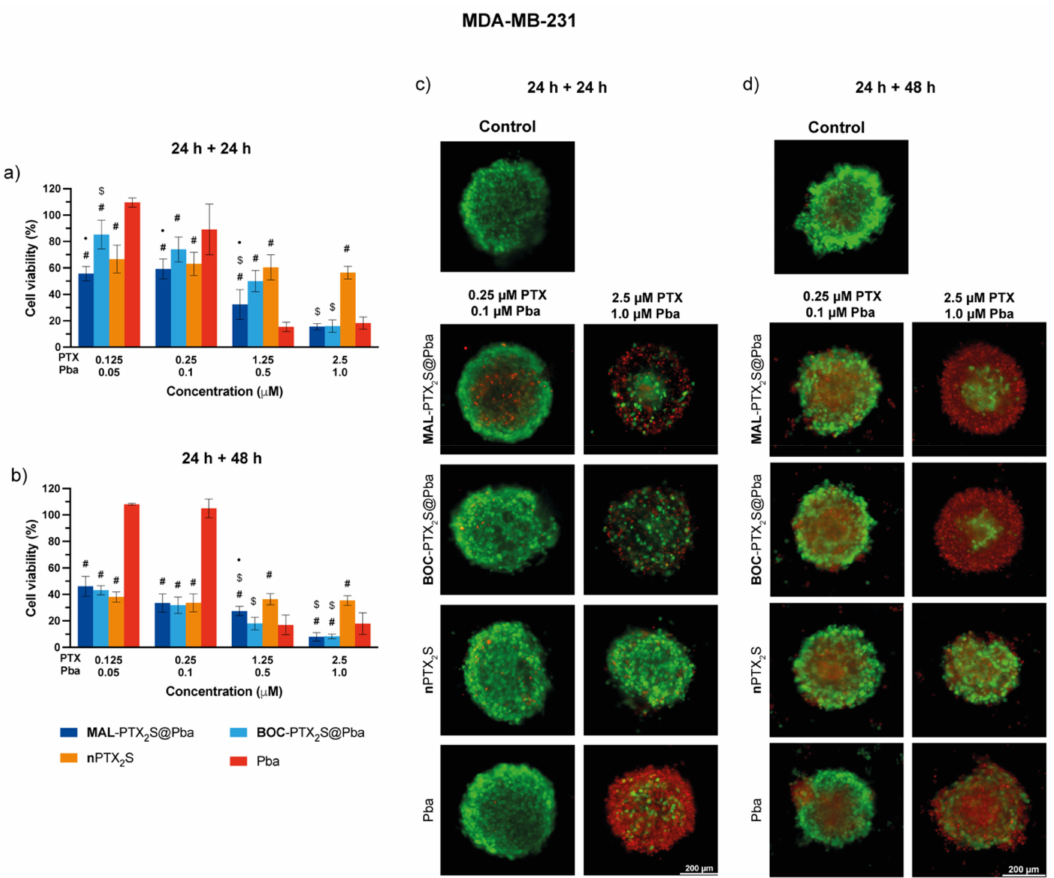
Figure 10. In vitro mono and combination therapy in MDA-MB-231 spheroids. The spheroids were incubated with the different drugs/combinations for 24 h and then irradiated with red light (1 J/cm 2 ); cell viability was measured by means of ATP reduction (3D Glo assay) 24 ( a ) or 48 h ( b ) post- irradiation. Data are expressed as mean percentage ± SD of at least two independent experiments, carried out in quadruplicate. Statistical significance was calculated applying the ANOVA Two-way with Bonferroni’s correction: • significantly different from BOC -PTX 2 S@Pba; # significantly different from Pba; $ significantly different from n PTX 2 S. Selected images of spheroids stained with the LIVE/DEAD kit and acquired with a fluorescence microscope 24 ( c ) or 48 h ( d ) after irradiation. Scale bars: 200 µ